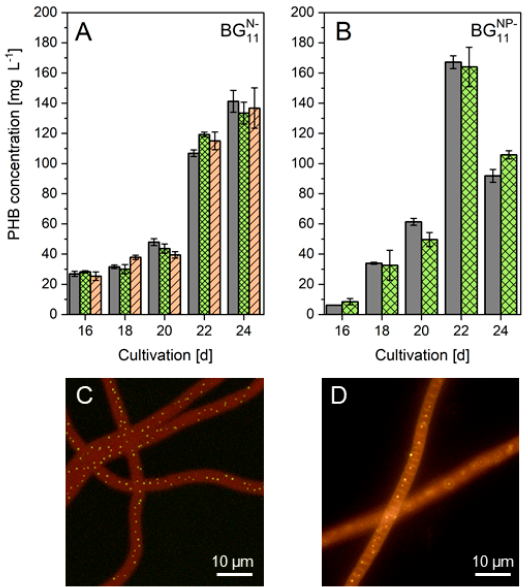
Figure 3. Fluorescent detection and bioimaging of PHB in Leptolyngbya sp. NIVA-CYA 255. PHB levels as revealed by HPLC (solid bars, grey), LipidGreen2 (crossed bars, green), and Nile red (dashed bars, orange) of BG 11N − ( A ) and BG 11NP − cultures ( B ). Data are the mean ± SD of three replicates. PHB granule bioimaging by LipidGreen2 ( C ) and Nile red ( D ).